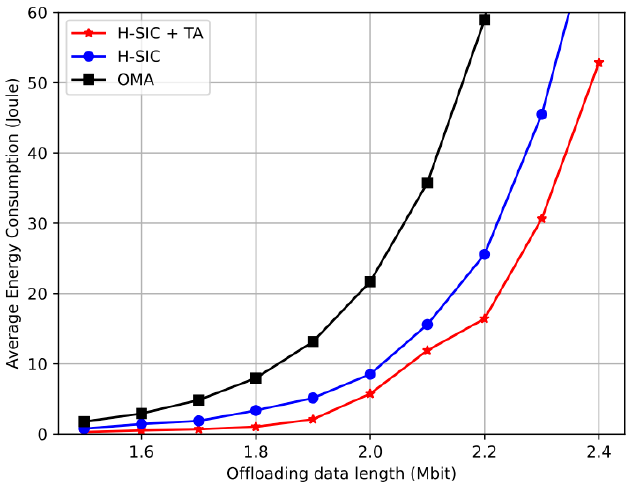
Figure 8. Average energy consumption versus the offloading data length [132].